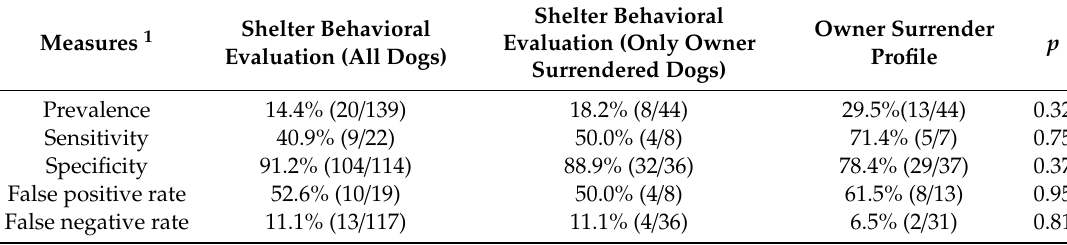
Table 7. Measures of prevalence and predictive abilities for shelter behavioral evaluations and owner surrender profiles with respect to behavior shown by dogs in adoptive homes when toys, bones, or other valued objects were taken away (Q1 on adopter survey). Measures for shelter behavioral evaluations are shown for all dogs included in the adopter survey ( n = 139; column 2) and for only those dogs that were owner surrendered and for which we had complete data ( n = 44; column 3). p value is from comparison of values in columns 3 and